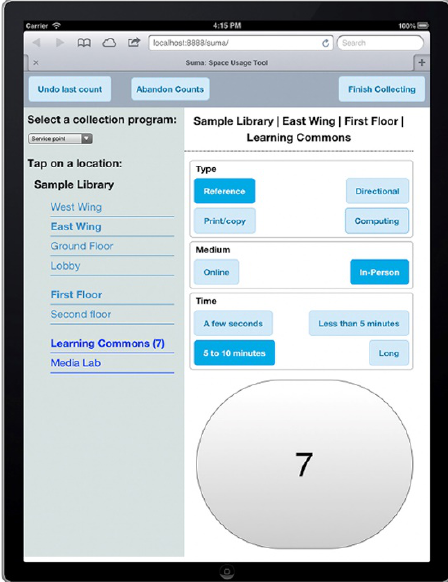
Figure 1 Suma data collection example